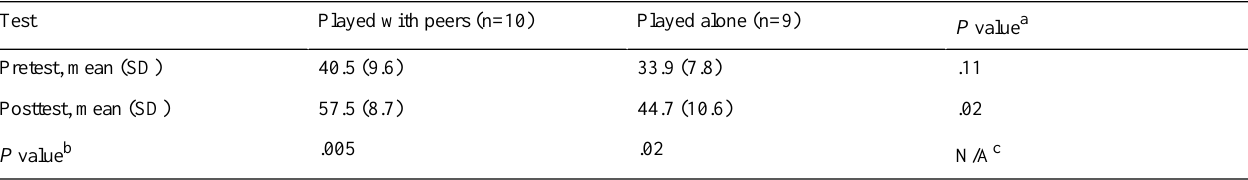
Table 1. General Physical Fitness Index